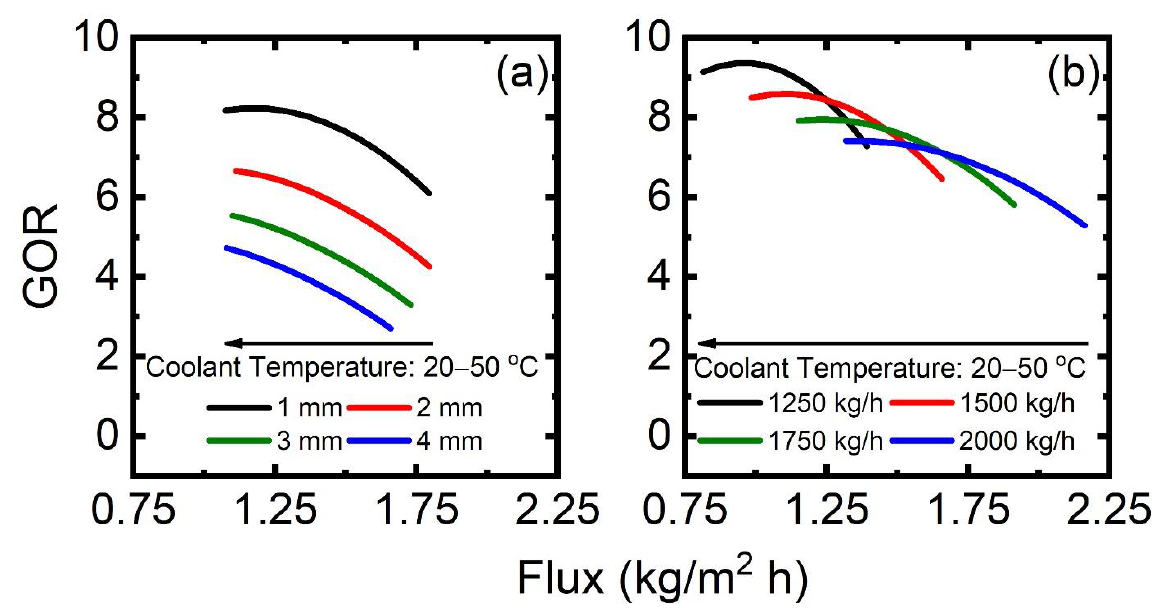
Figure 9. GOR – flux performance for permeate conditions in AGMD with varying coolant temperature of 20 – 50 °C for ( a ) air gap thickness of 1 – 4 mm and ( b ) coolant flow rate of 1250 – 2000 kg/h. Note that GOR and flux are calculated from the AGMD-based desalination process in each condition.